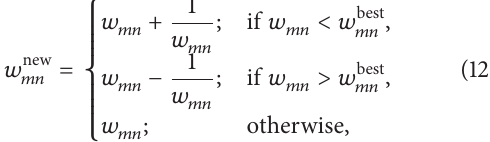
Figure 2: Adaptive and conventional ABC algorithms performance in terms of their nectar values.